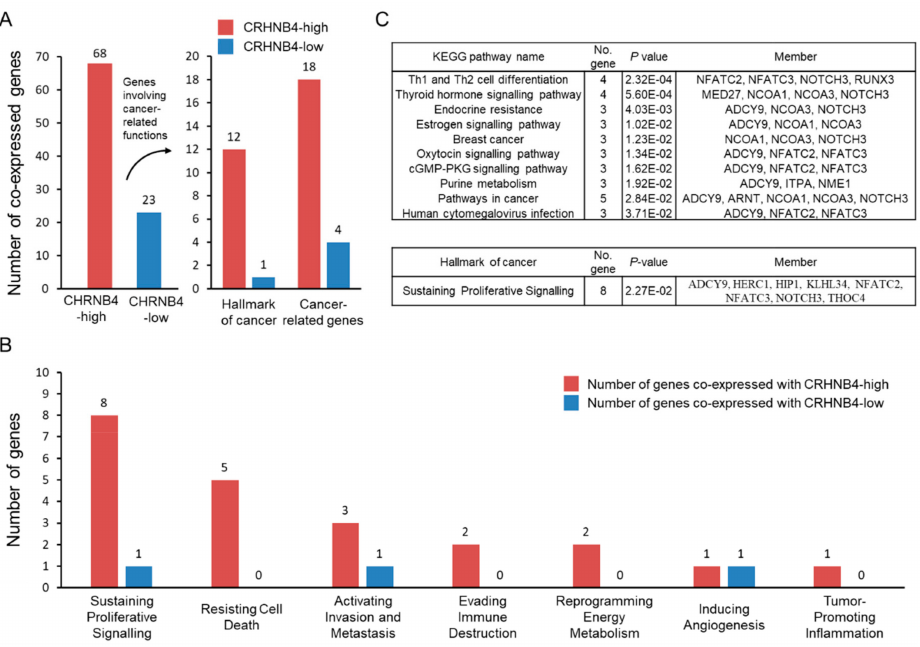
Figure 3. Association between cancer-related functions and CHRNB4 co-expressed genes of CHRNB4-high / low patients. ( A ) Number of co-expressed genes with CHRNB4 in the CHRNB4-high and -low subgroups involved in cancer hallmark and cancer-related functions. ( B ) The histogram